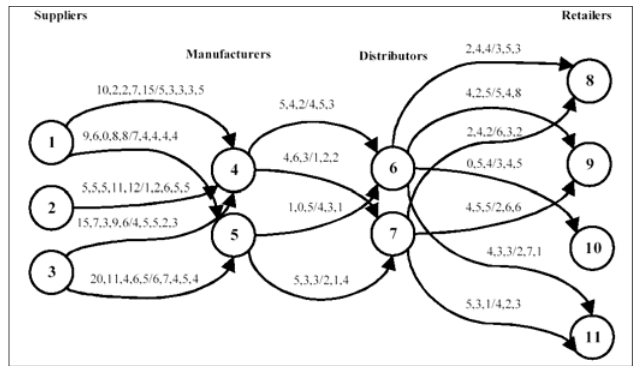
Figure 6. Example of a supply chain with 3-products Using proposed coordination mechanism, Model (I) consists of 66 decision variables and 87 constraints and Model